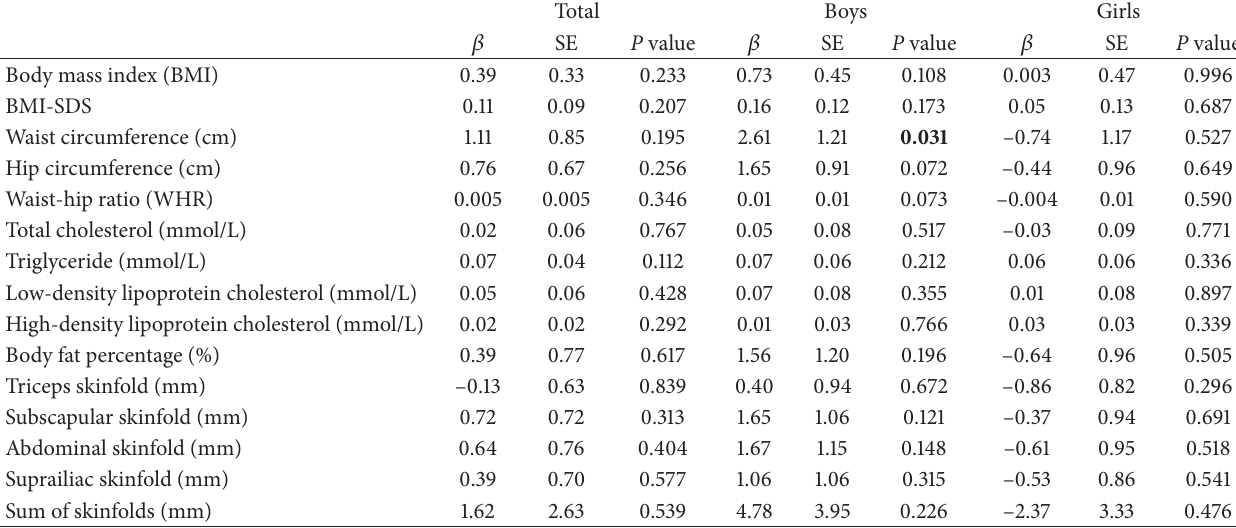
Table 3: Associations of the -102G > A polymorphism with obesity-related phenotypes in girls and boys. Total Boys